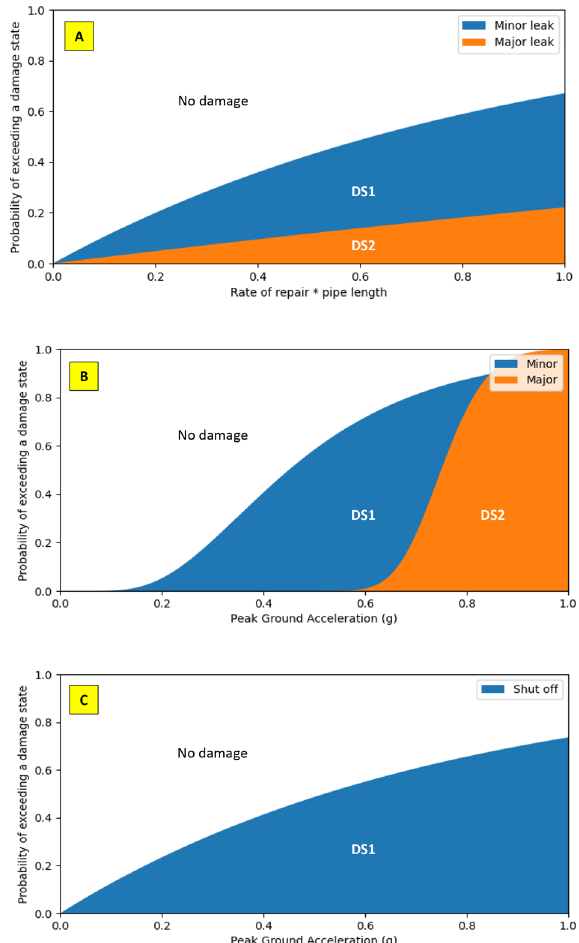
Figure 4. Fragility curves and damage states for ( A ) pipe, ( B ) tank, and ( C )